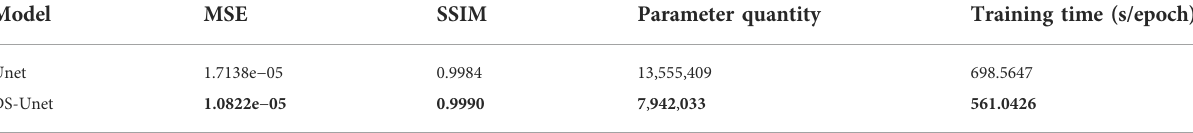
TABLE 1 Comparison of two networks on SEG C3 synthetic data (the bold font indicates the best